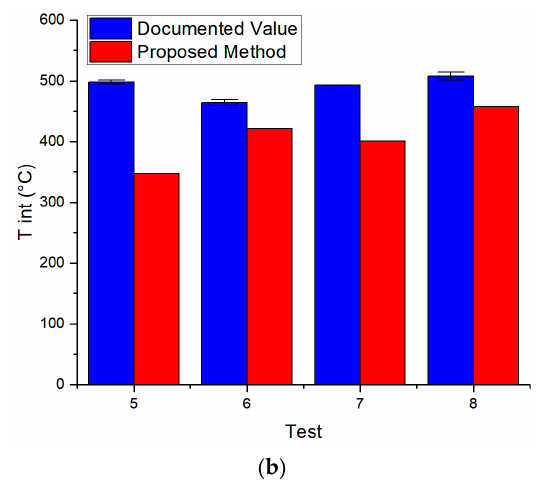
Figure 7. Temperature predictions for machining Al 6082-T6 aluminum. The average temperatures in the primary shear zone are shown in ( a ); The average temperatures in the secondary shear zone are shown in ( b ). The documented values are predicted values adopted from the literature [41].